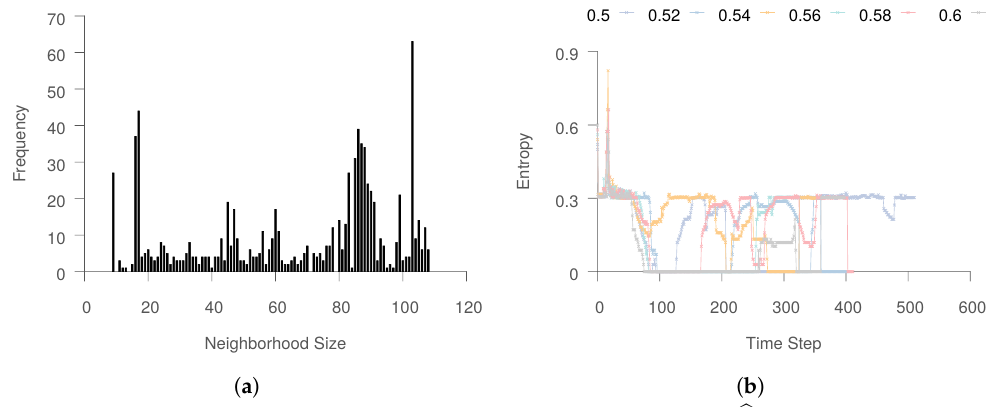
Figure 7. Entropy-Isomap with the default k = 8 and entropy threshold (cid:98) H = 0.3 run for data with χ = 3.0 and the variables φ ∈ { 0.50,0.52, 0.54,0.56,0.58, 0.6 } . (Please view in color). ( a ) Distribution of selected neighborhood sizes k i that did not reach the maximum M = 100. ( b ) Entropy of the discovered neighborhood for each time